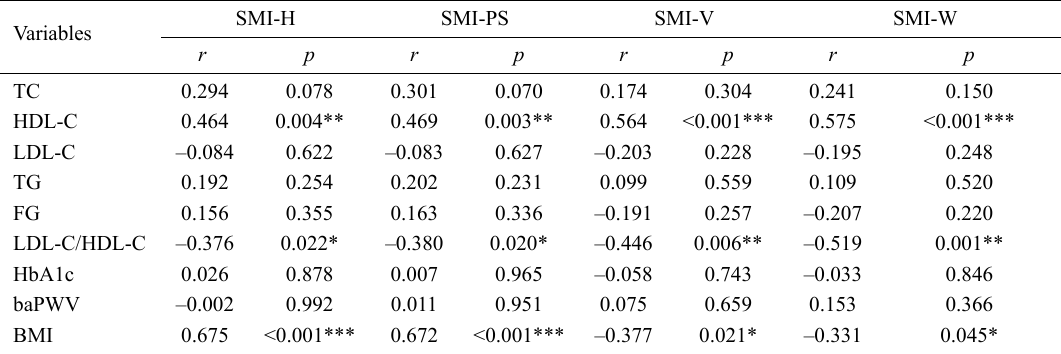
Correlation coefficients ( r ) and p values were calculated using the Pearson’s correlation analysis, and in the case of variables not following the normality, Spearman’s correlation analysis was used. baPWV, brachial-ankle pulse wave velocity; BMI, body mass index; FG, fasting glucose; HDL-C, high density lipoprotein cholesterol; HbA1c, hemoglobin A1c; LDL-C, low density lipoprotein cholesterol; LDL-C/HDL-C, LDL-C to HDL-C ratio; TC, total cholesterol; TG, triglyceridel;